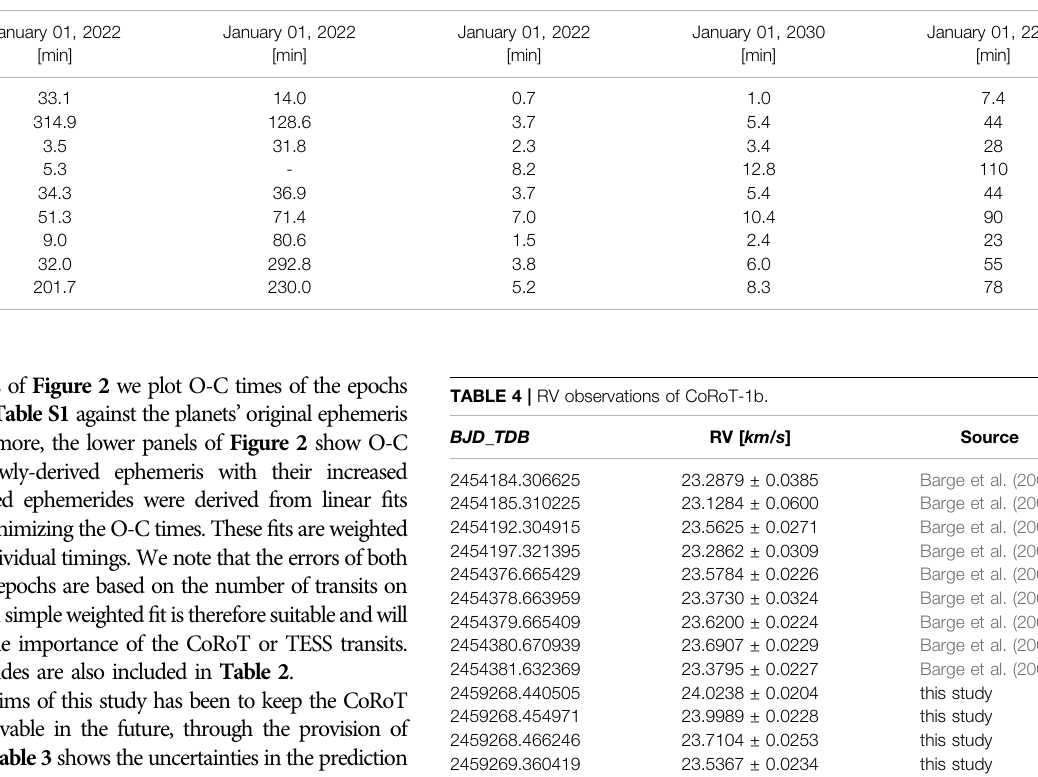
TABLE 3 | Current and future uncertainties of transit epochs, from original, standardized and updated ephemerides, for the indicated dates. Planet Orig. Ephem